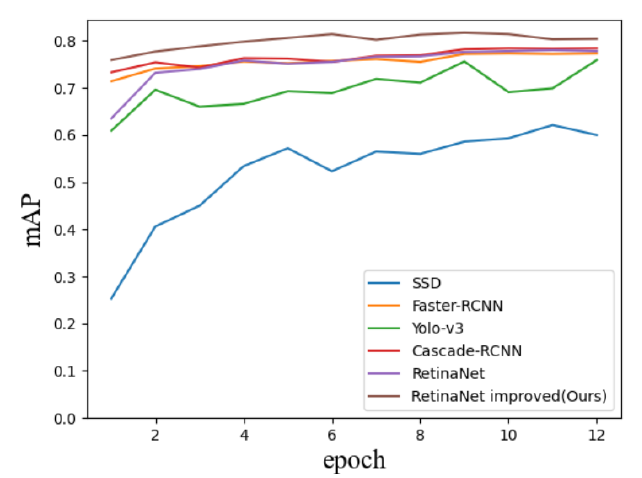
Figure 8. Diagram of mAP of different models. The brown is our